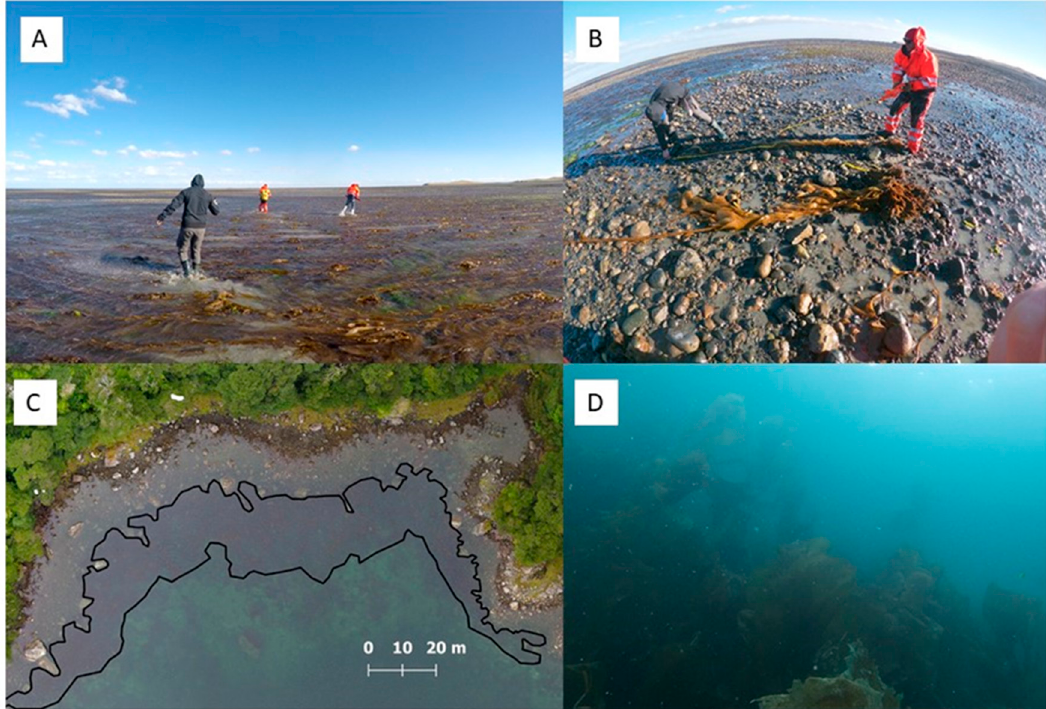
Figure 6. ( A ) Buque Quemado intertidal forest (Strait of Magellan) at 10 cm of depth in low tide and 9 m in high tide. ( B ) Measuring the length of the plants of site A. (The people in photos A and B are included for scale.) ( C ) A permanent subtidal forest (delineated in black) in Puerto Amparo (area = 0.3 ha). ( D ) The underwater canopies of Puerto Amparo (max. depth: 7.9 m). (Photos: Alejandra Mora S.).